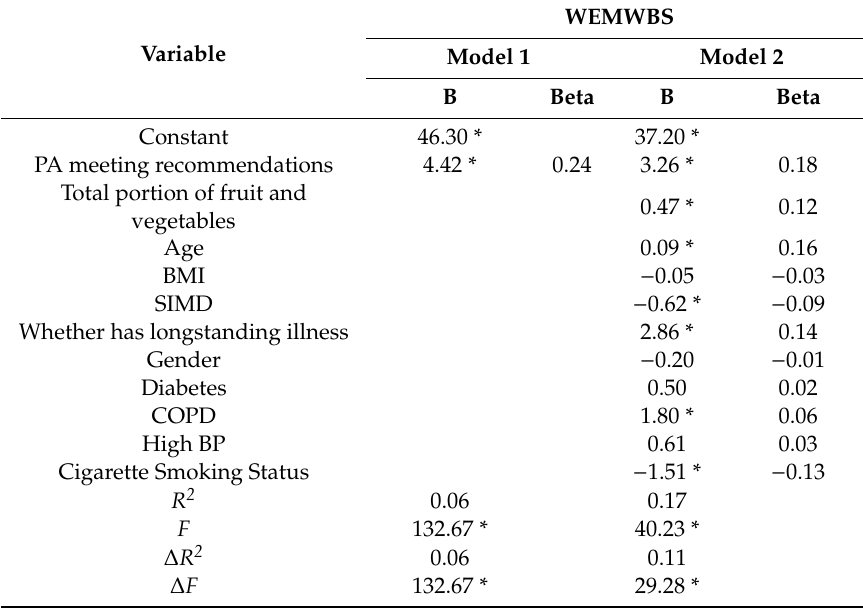
Table 4. Full details on each regression